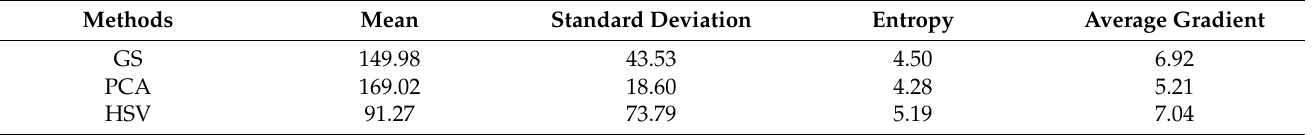
Table 5. The quantitative evaluation indexes of multi-source data